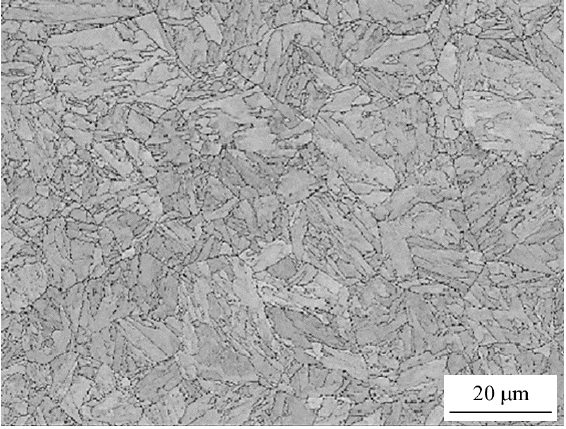
Figure 1. Scanning electron microscopy (SEM) micrograph of ferritic-martensitic grade P91 steel (1050 °C/0.5 h/AC + 750 °C/1 h/AC).